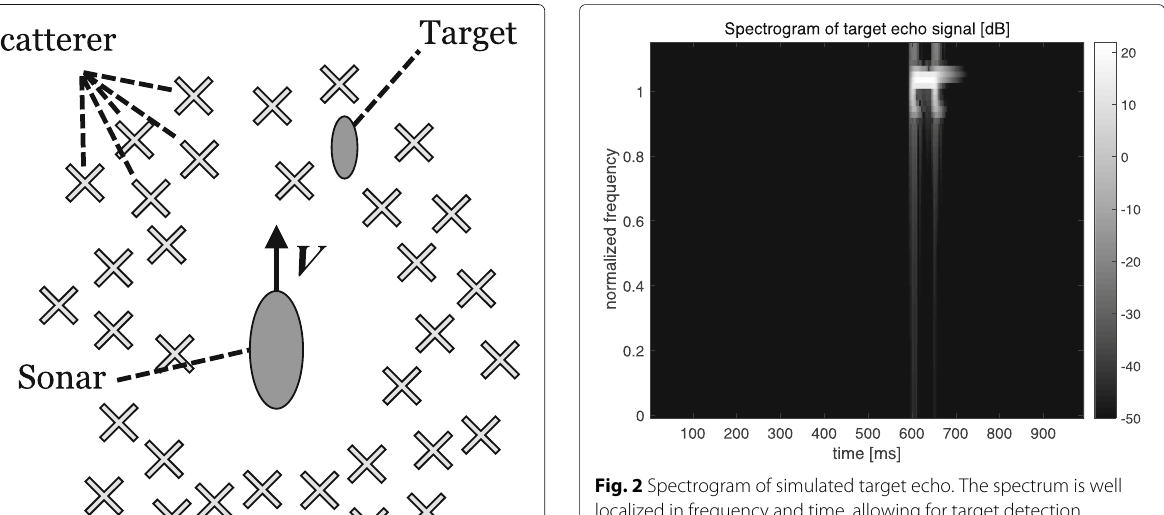
is a narrowband signal with frequency f 0 + f d , whereas the reverberation is a broadband signal in the range (cid:2) (cid:2) (cid:3) (cid:3) − 2 V 2 V f 0 < f < f 0 , as verified in (2) and (4), respec- c c